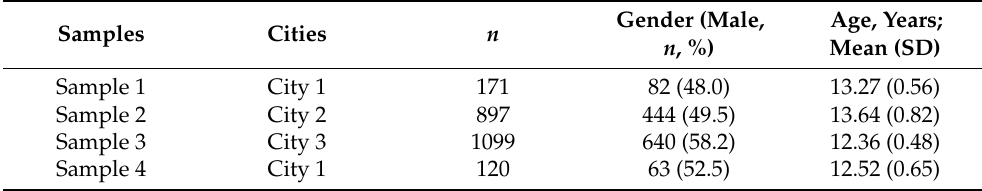
Table 3. Socio-demographic characteristics of the